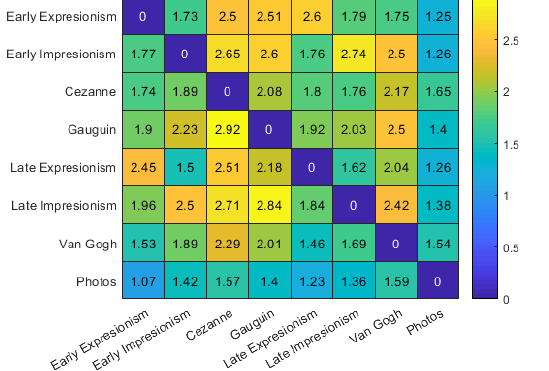
Figure 6. Average reaction times between styles in seconds. Row labels denote the identity of the target stimulus, column labels denote the identity of the distractor stimulus. Times are given in seconds.